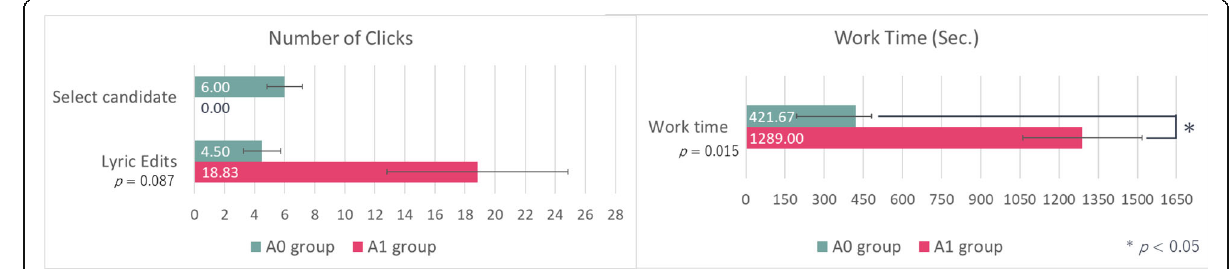
Fig. 8 Comparison of number of clicks and work time between A0 and A1 groups